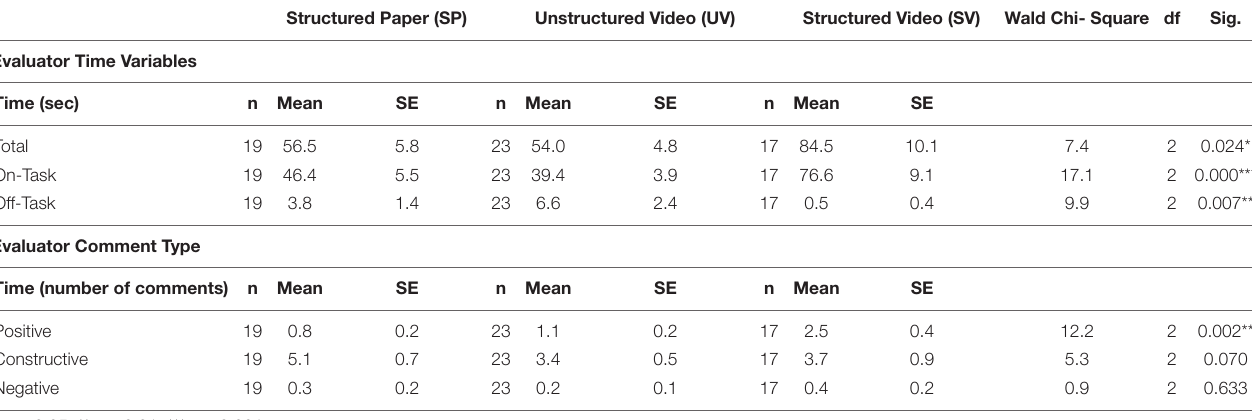
TABLE 3 | Estimate marginal mean and standard error of variables for evaluator by engagement time and comment type. Structured Paper (SP) Unstructured Video (UV) Structured Video (SV) Wald Chi- Square df Sig.